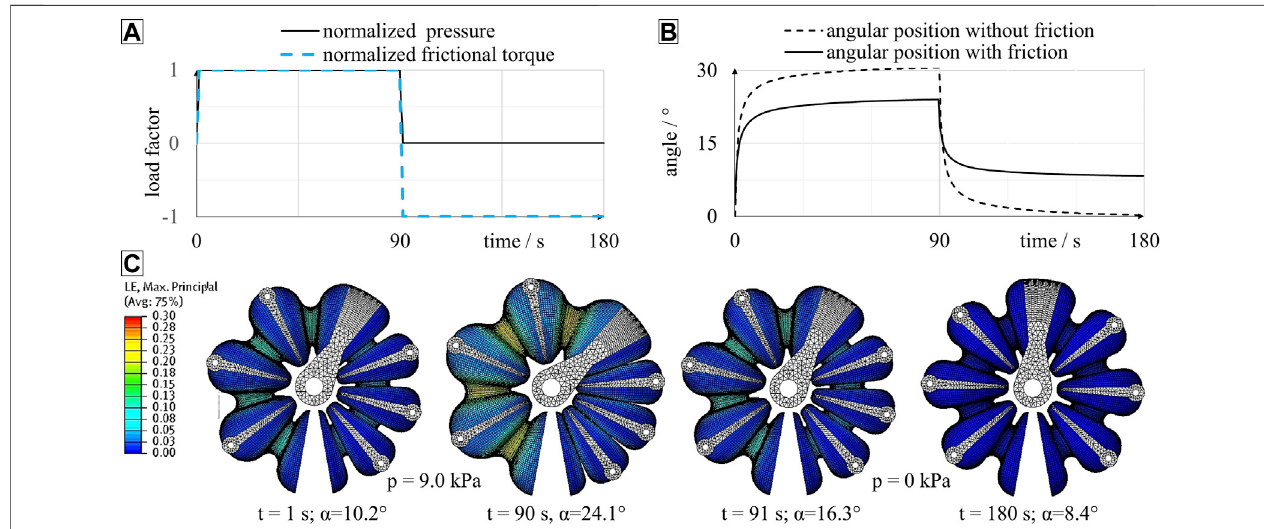
FIGURE 11 | FEA of a novel inkjet-printed rotary bellows actuator including the de fi nition of loads (A) , evaluation of time-dependent angular de fl ection (B) and structuraldeformation (C) .Asshownin (A) ,apressureloadand(optional) torqueloadswerede fi nedtosimulatea90 s-intervalofpressurizationfollowedby90 sofzero pressure. Asshown in (B) ,angular de fl ection isconsiderablytime-dependentduring phasesofconstantpressure. Theconsiderationoftorque loadscauses adecrease in maximum angle at 90 s and an increase in residual angle at 180 s. As shown in (C) , signi fi cant time-dependency can also be observed by evaluation of strain distribution and structural deformation. In this simulation run pressure loads of 9.0 kPa and torque loads of 1.8 Nmm were considered.